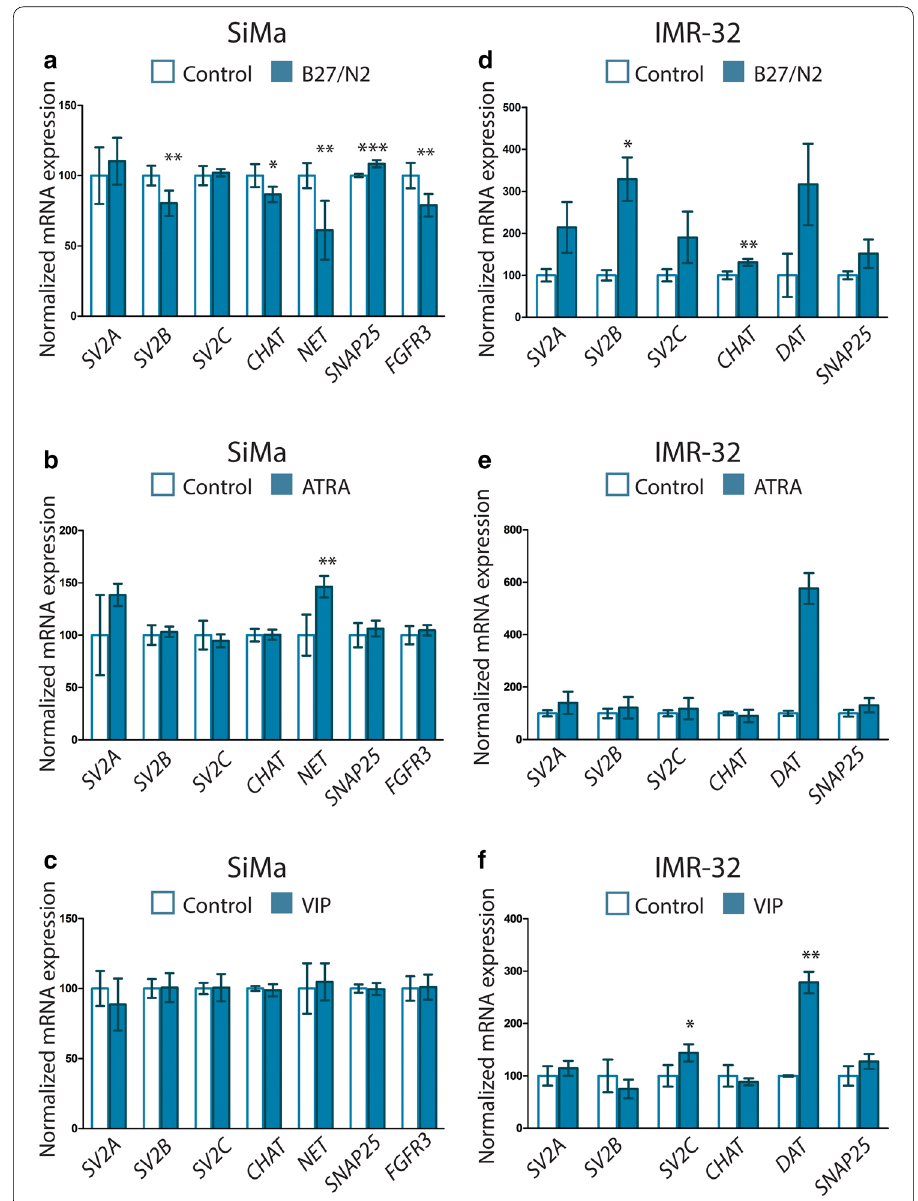
a short time (0.5 h–96 h) reveal fluctuating levels of proto-oncogene MYCN over the time-course of the experiment [53], indicating a too dynamic time period. A screen of several RA differentiated neuroblastoma cell lines revealed seven days to be an optimal time for the proto-oncogene RET response in IMR-32 cells [27] and long differentiation times steadily increase neurite growth for some neuroblastoma cell lines treated